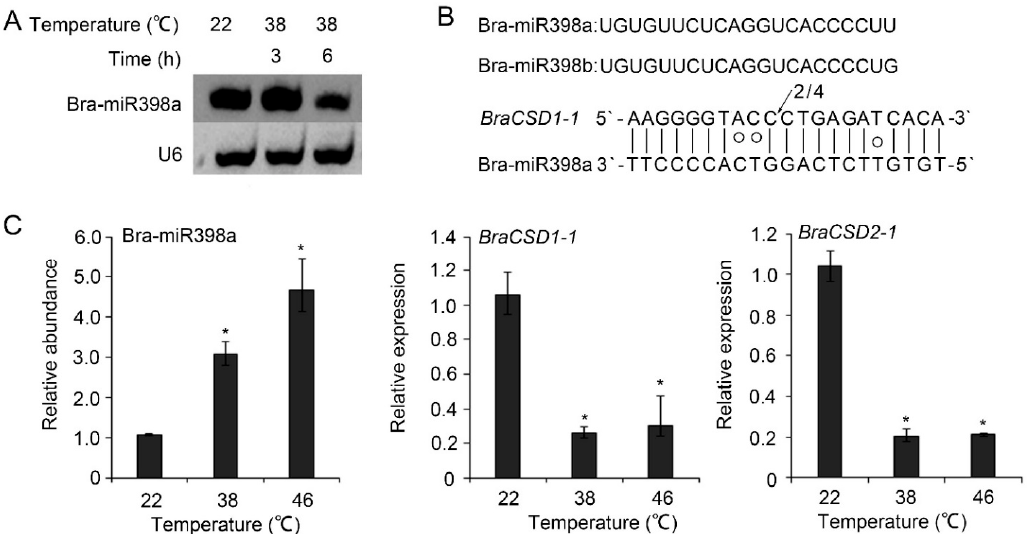
Figure 2. The response of miR398 and its target genes to heat stress. ( A ) Northern blotting showing miR398 abundance under high temperature (38 °C for 3 h and 6 h). ( B ) 5 ′ RACE PCR showing the cleavage sites of BraCSD1-1 . Numbers indicate the fraction of cloned PCR products terminating at the position. ( C ) Real-time PCR showing relative abundance of Bra-miR398a and its target genes under 22 °C, 38 °C, and 46 °C for 1 h. The asterisks indicate a significant difference (* represents p < 0.05) (Student’s t -test).